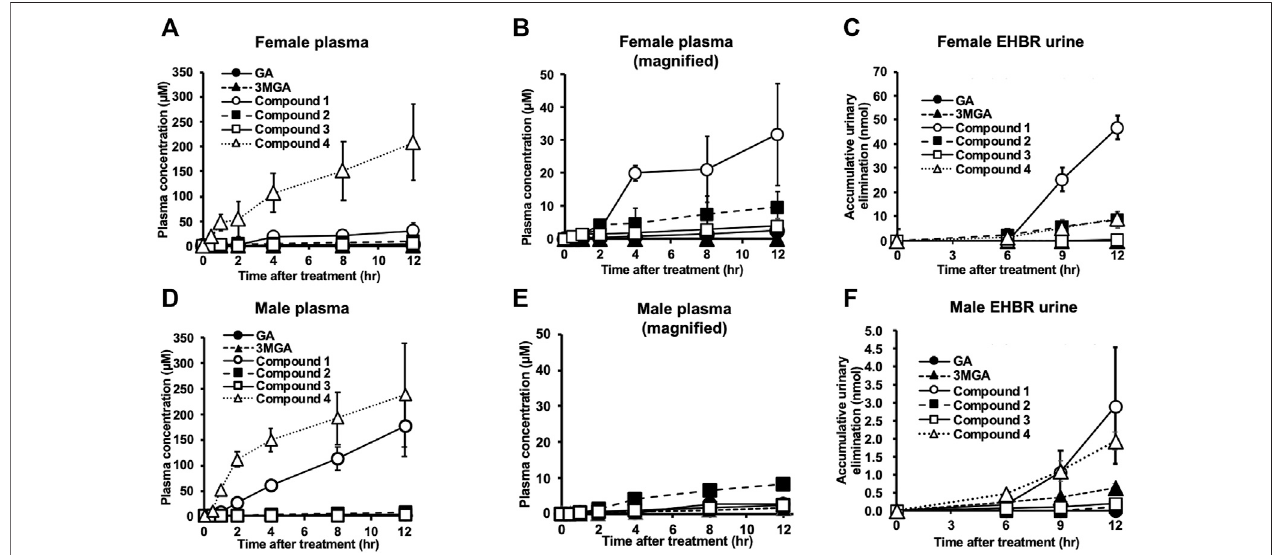
FIGURE 5 | Pharmacokinetic pro fi les of glycyrrhizin (GL) metabolites in female (A – C) and male (D – F) Eisai hyperbilirubinuria rats (EHBRs). Glycyrrhetinic acid (GA, 200 mg/kg)wasadministeredorallytoanesthetizedEHBRs,andplasmaandurinewerecollectedfor12 h.DataofGA,3MGA, 1 , 2 ,and 3 in (A) andGA,3MGA, 2 ,and 3 for (D) are relatively small; their magni fi ed graphs are shown in (B,E) , respectively. Concentrations of GA metabolites were measured using liquid chromatography- tandem mass spectrometry (LC-MS/MS), and data are means ± standard error (S.E: n (cid:2)